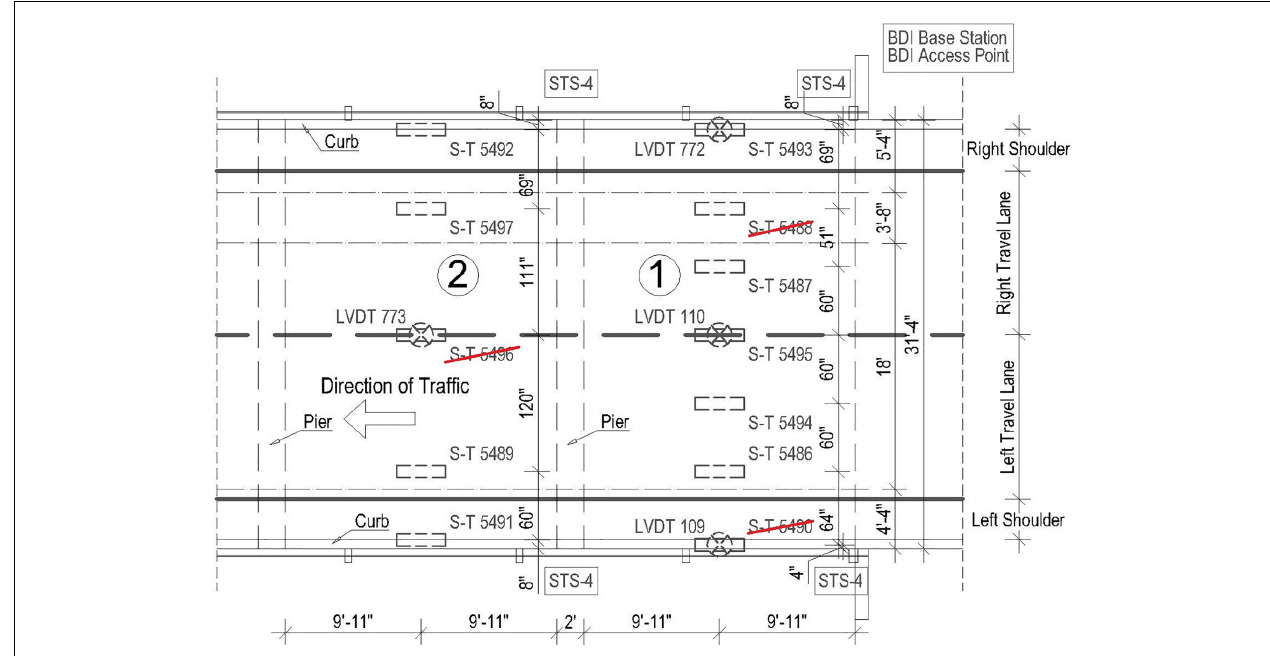
FIGURE 6 | Strain transducers (S-T XXXX) and LVDT’s (LVDT XXX) locations.